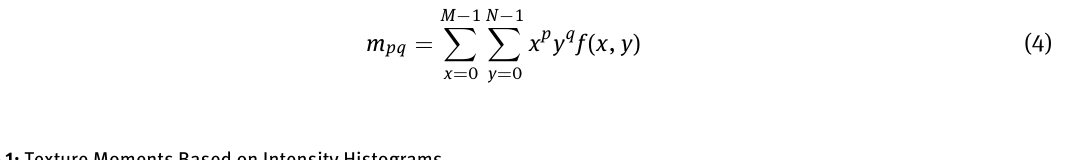
Table 1: Texture Moments Based on Intensity Histograms.